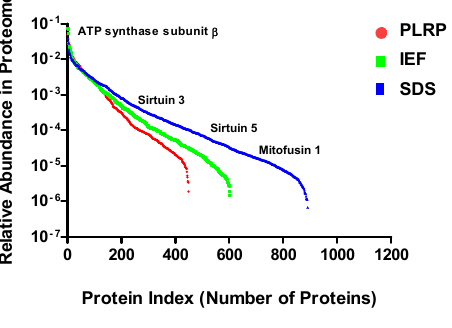
Figure 4. Relative abundance of mitochondrial proteins sampled with each platform.